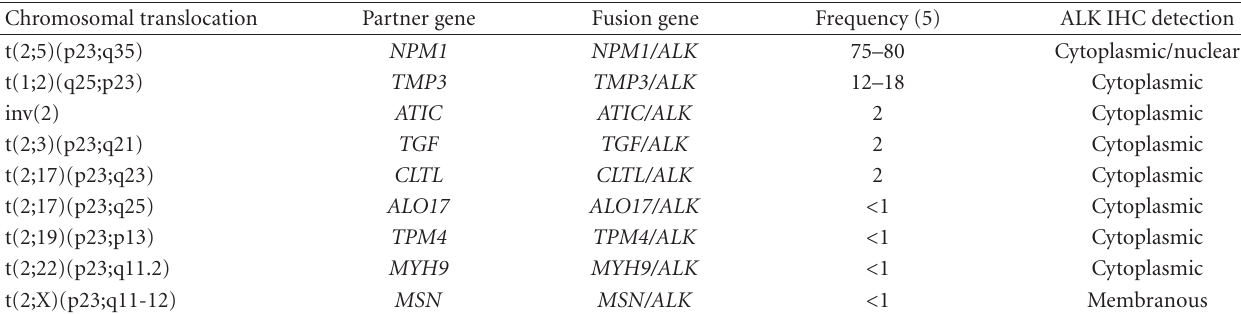
Table 1: Main translocation involving ALK recorded in anaplastic large cell lymphoma.